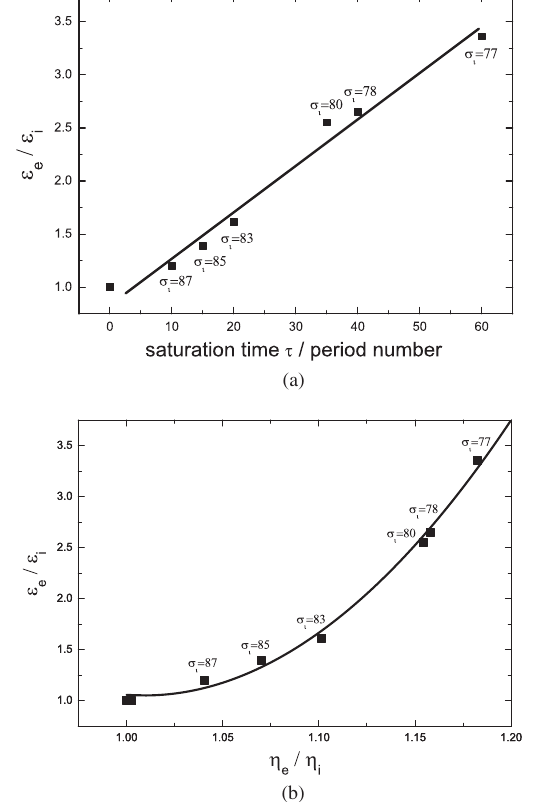
FIG. 5. Simulationresults showing final relative emittancegrowth for initial parabolic distribution ( η i ¼ 0 . 8 ) with 30 K macroparticles as functions of (a) saturation time τ and (b) η e = η i (down).